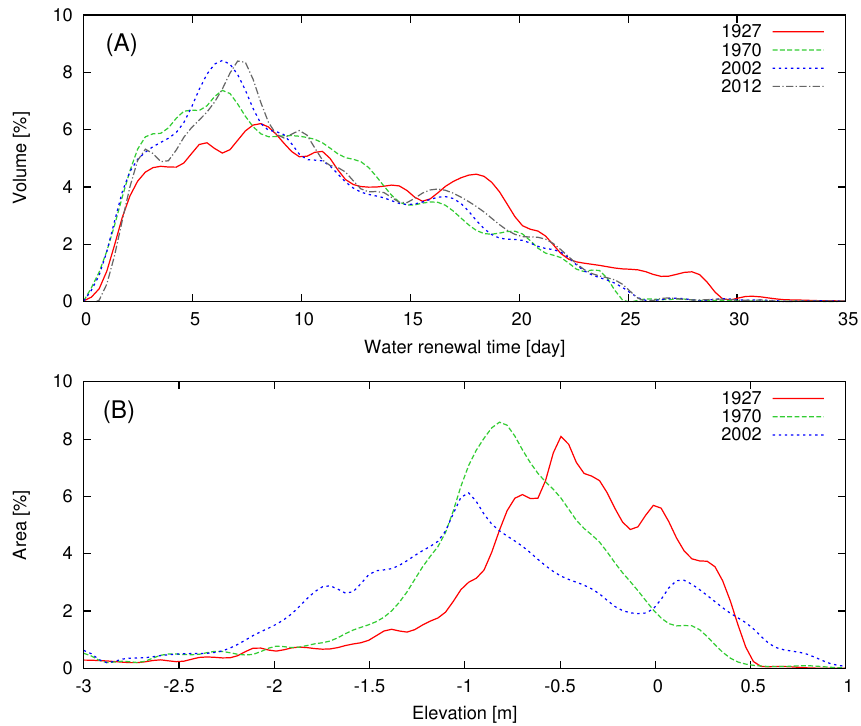
Fig. 5. Frequency distribution of water renewal time, by % of volume (A) , and elevation (referred to IGM42 datum), by % of area (B) , for the 1927 (red continuous line), 1970 (green dashed line), 2002 (blue dotted line) and 2012 (gray dot-dashed line) scenarios. There is no available elevation dataset for the 2012 scenario and therefore the elevation over the lagoon was assumed to be unchanged from year 2002.